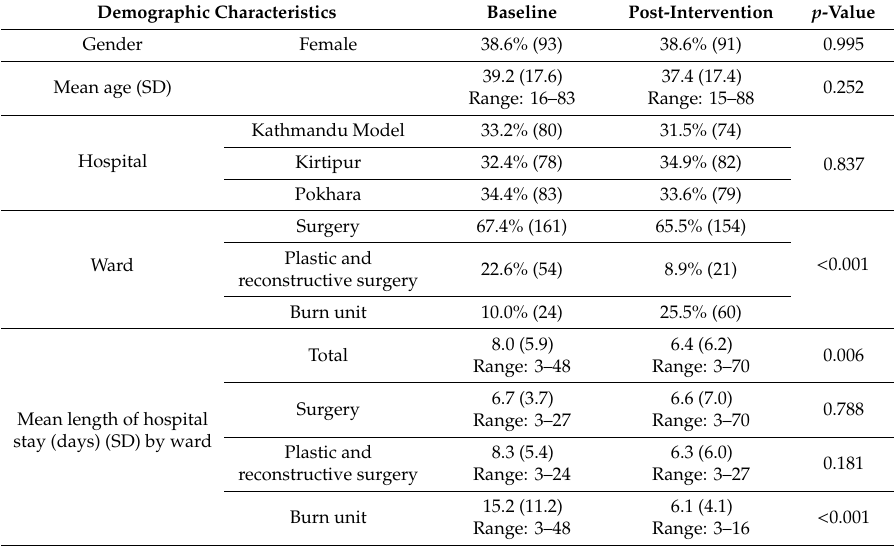
Table 1. Baseline and post-intervention patient characteristics, length of hospital stay, and distribution across hospital sites and wards.